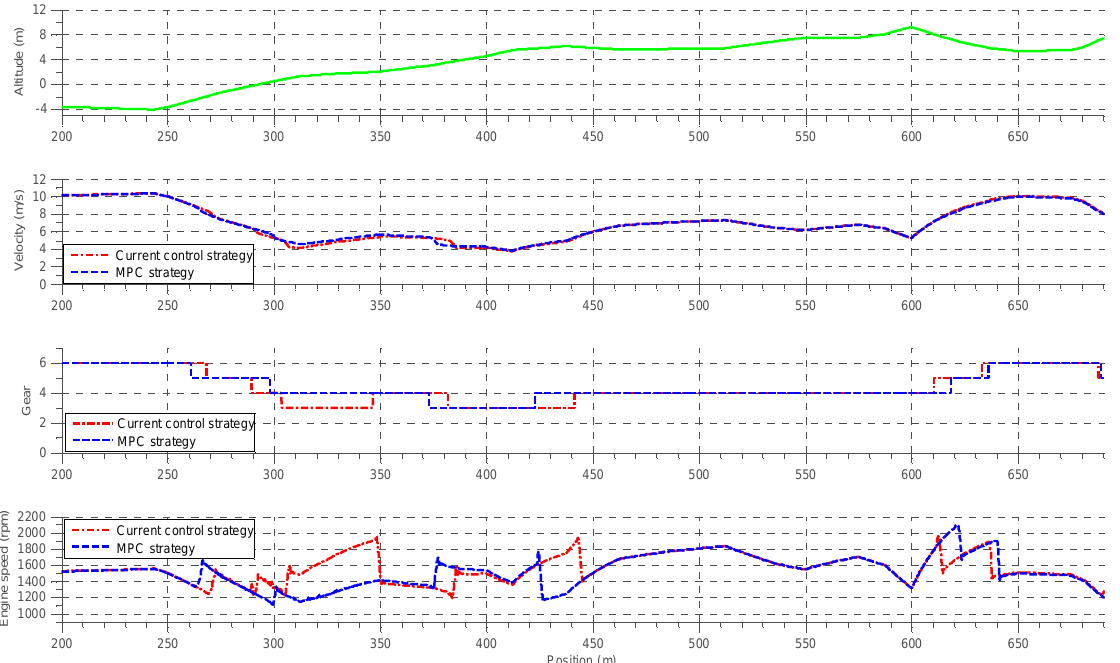
Figure 6. Simulation result on a road stretch of Målajord. The MPC strategy gives a fuel reduction of 1.88% and simultaneously a decrease in travel time of 1.34%.